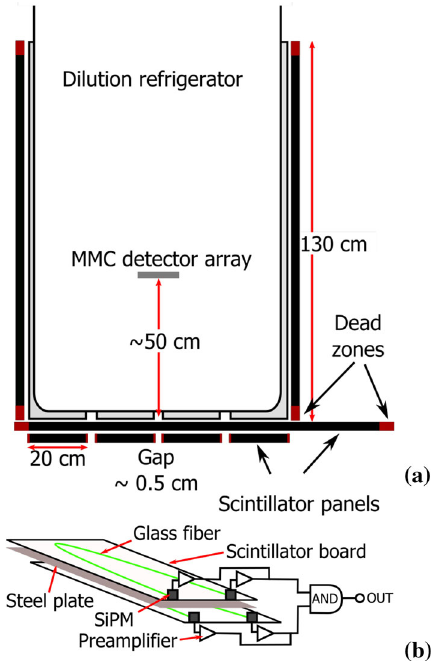
Fig. 7 a Section of the muon veto surrounding the ECHo dilution refrigerator. Four of 24 polystyrene based scintillator panels (shown in black) are placed at each side of the refrigerator (shown in white). A second layer of 4 panels are placed on the bottom crossed to the other bottom panels to compensate the missing layer on top of the cryostat. b A panel consists of two scintillator boards separated by a steel plate. The produced light is collected by an embedded u-shaped glass fiber and read out by two SiPMs at each end of the glass fiber